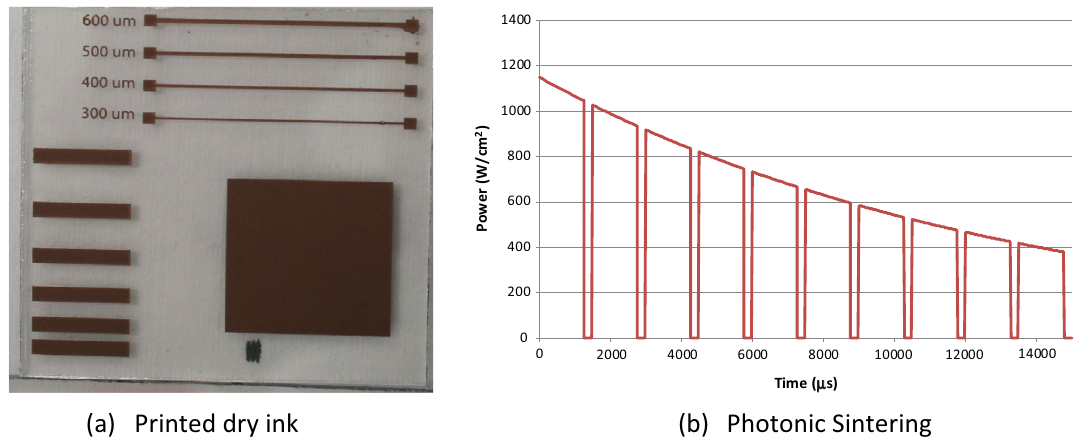
Figure 2. Printed dry but un-sintered image ( a ) and ( b ) and an example of a 10-pulse photonic energy profile (energy density of 8.9 J/cm 2 ).